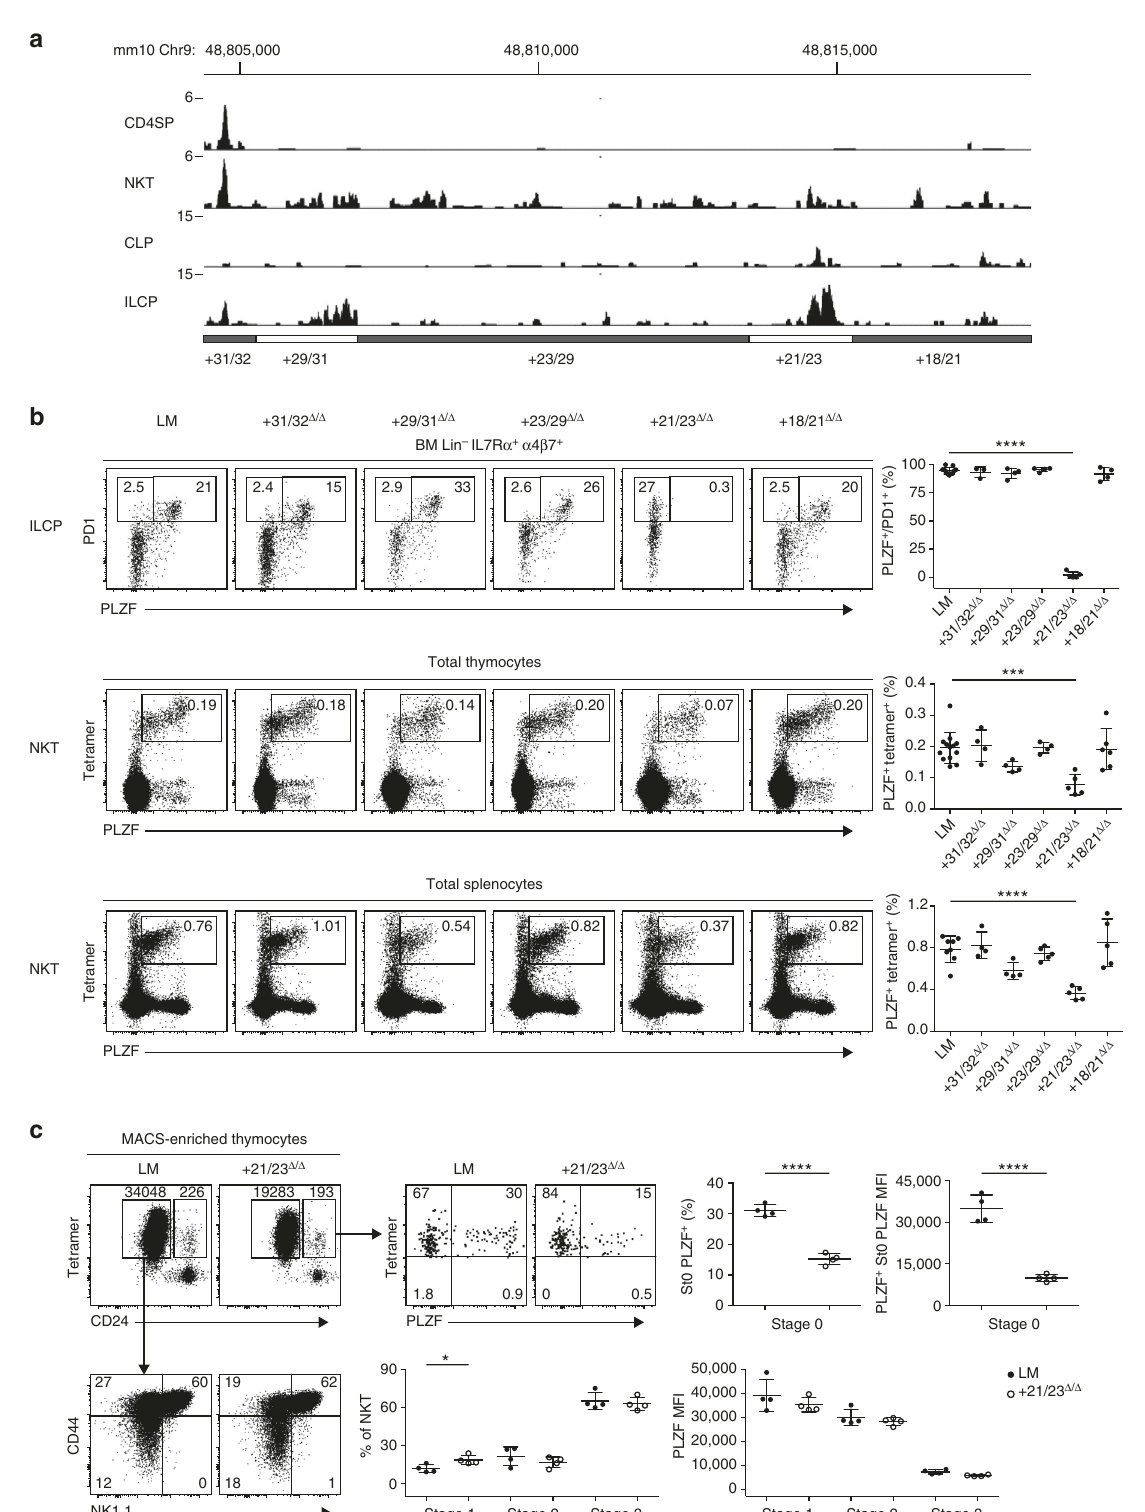
Fig. 3 Dissection of the + 18/32 region. a ATAC-seq tracks. b FACS analysis of BM ILCP ( upper row ) and NKT thymocytes ( middle row ) and splenocytes ( bottom row ) in mice carrying the indicated deletions. Summary data in the right column are compiled from six independent experiments, with a total of 4 – 13 mice in each group. One-way analysis of variance for multiple comparisons was used for statistical analysis. c FACS analysis of NKT developmental stages and PLZF expression in + 21/23 Δ / Δ mice and littermate controls (LM). Data are combined from two independent experiments with a total of four mice per group. Two-tailed Student ’ s t -test was performed. * P < 0.05, ** P < 0.01, *** P < 0.001, **** P <